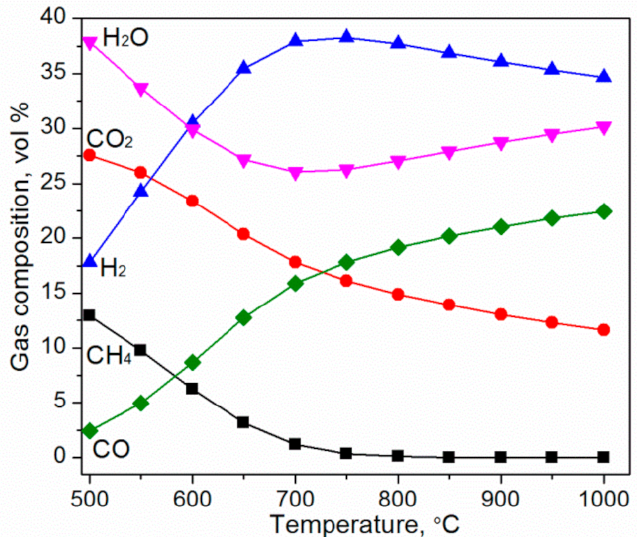
Figure 2. Bio-syngas composition at the equilibrium state in the temperature range between 500 and 1000 ◦ C at 1 bar. Initial feed composition, CH 4 /CO/CO 2 /H 2 /H 2 O = 1/2.3/2.1/2.7/5.6 (40 mol%